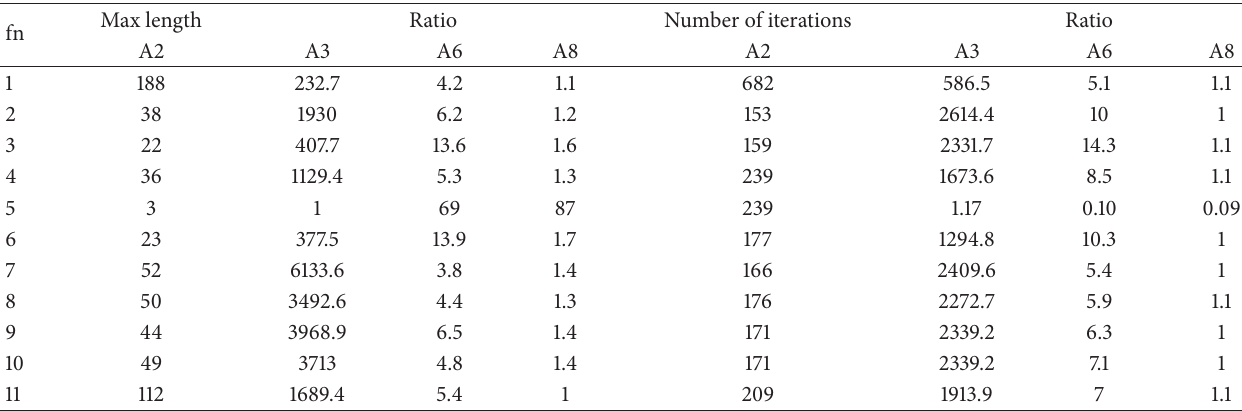
Table 4: The maximum list length from A2 and the ratio of the maximum list length from A3, A6, and A8 to the maximum list length from A2 when 𝑛 = 10 . Also the result of the number of